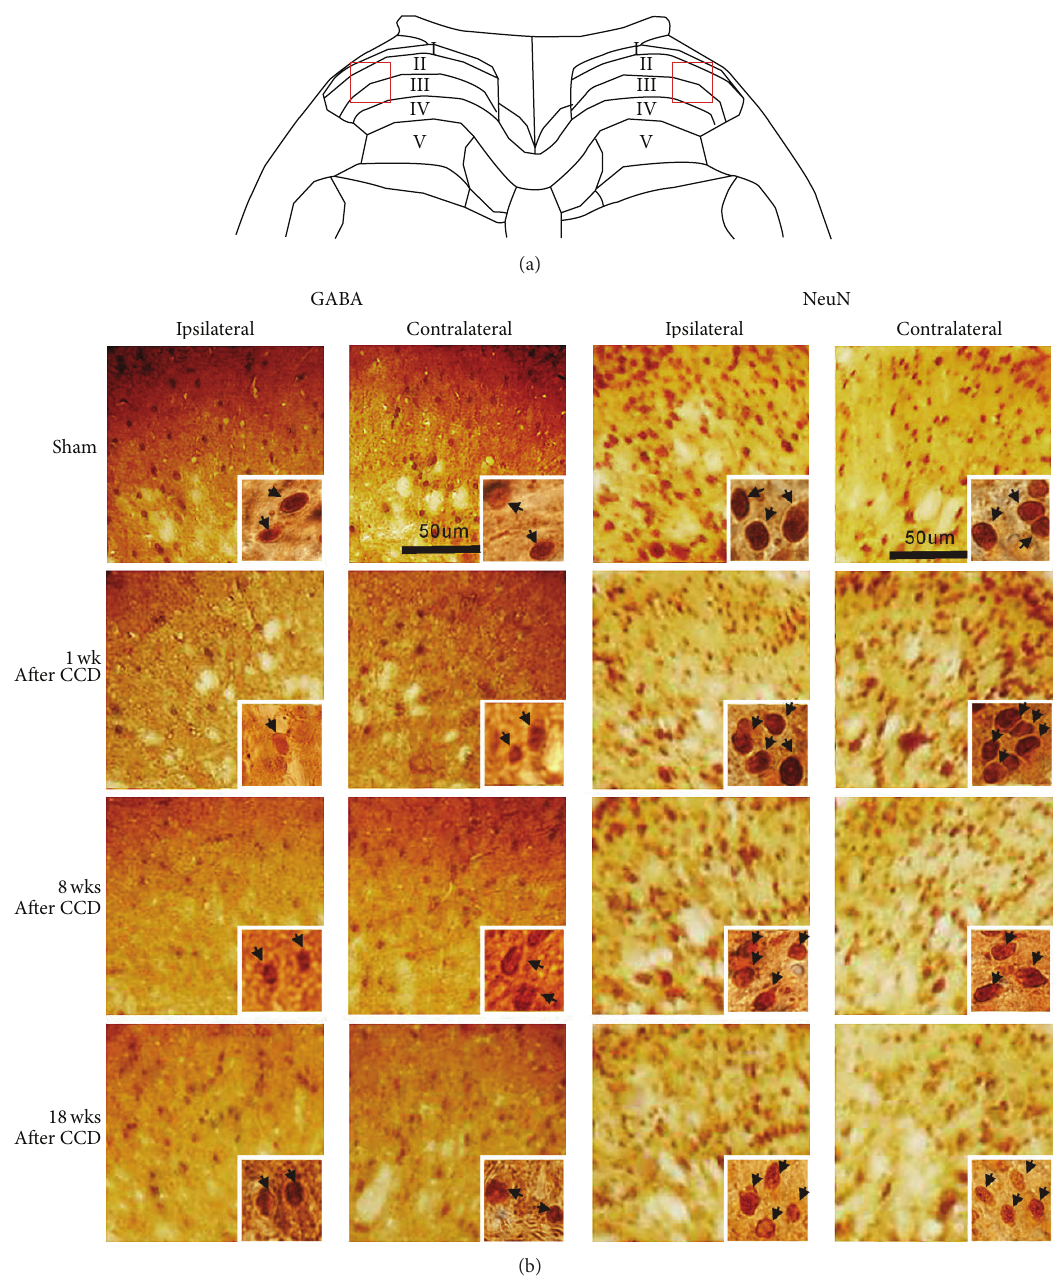
Figure 2: Representative images of GABA-ir and NeuN-ir cells in laminae I–III of the spinal dorsal horn. Photomicrographs of the areas of the squares are presented in (a), which cover the lateral portions of laminae I–III, and are shown in (b). The GABA-ir cells in the ipsilateral laminae I–III appear to be distributed less densely for 1-week and 8-week post-CCD groups than for sham-operated and 18-week post-CCD groups, with no density difference in the contralateral laminae among the four groups. The NeuN-ir cells show no differences in density between both sides of the dorsal horn laminae as well as among all four groups. Typical GABA-ir and NeuN-ir cells are seen in insets at the lower right of each image (indicated by